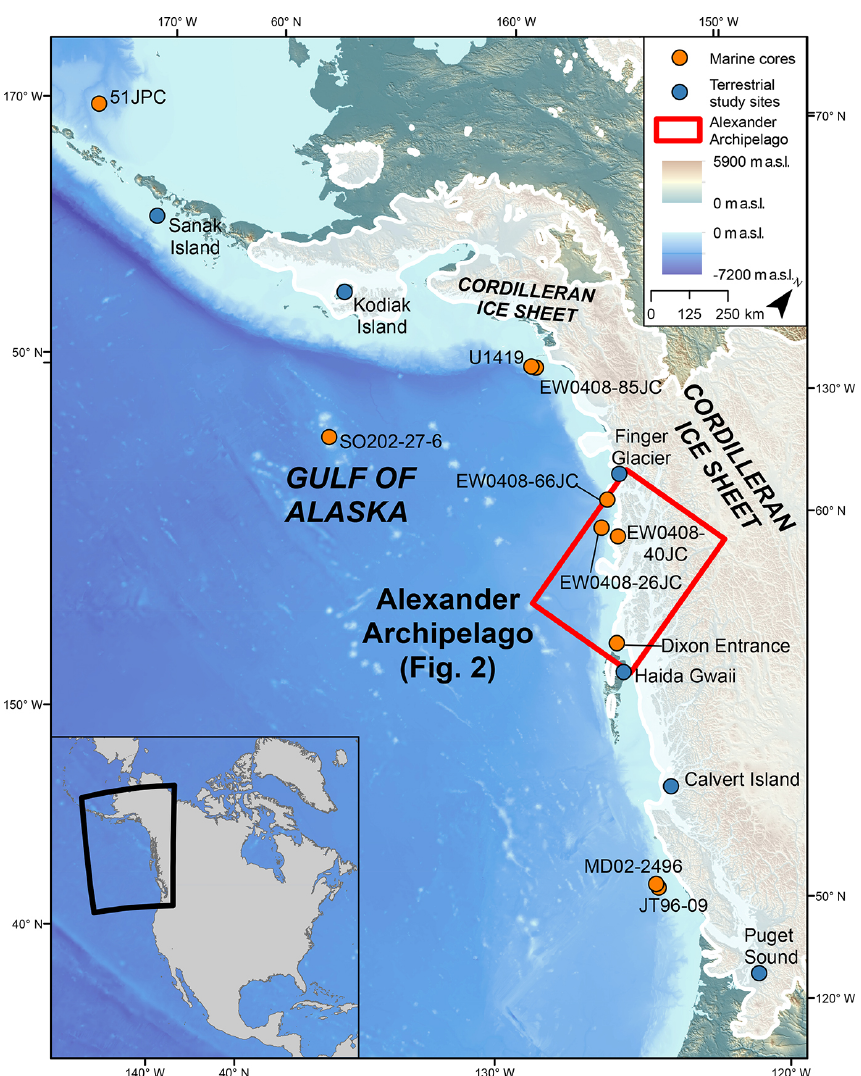
Figure 1. Map of the North Pacific region showing ice limits at 18.0ka from Dalton et al. (2020) with location of relevant sites mentioned in the text. The Alexander Archipelago is highlighted by the red box on the main figure. Orange dots indicate locations of marine sediment cores: 51-JPC (Caissie et al., 2010), SO202-27-6 (Maier et al., 2018), U1419 (Walczak et al., 2020), EW0408-85JC (Davies et al., 2011; Praetorius and Mix, 2014, Praetoruis et al., 2015), EW0408-66JC (Praetorius and Mix, 2014; Praetorius et al., 2016), EW0408-26JC (Praetorius and Mix, 2014; Praetorius et al., 2016), EW0408-40JC (Addison et al., 2010), MD02-2496 (Cosma et al., 2008), and JT96-09 (Kienast and McKay, 2001). Blue dots indicate location of terrestrial study sites: Sanak Island (Misarti et al., 2012), Kodiak Island (Mann and Peteet, 1994), Finger Glacier (Mann, 1986), Haida Gwaii (Clague et al., 1982; Mathewes and Clague, 2017), Calvert Island (Darvill et al., 2018), and Puget Sound (Porter and Swanson,